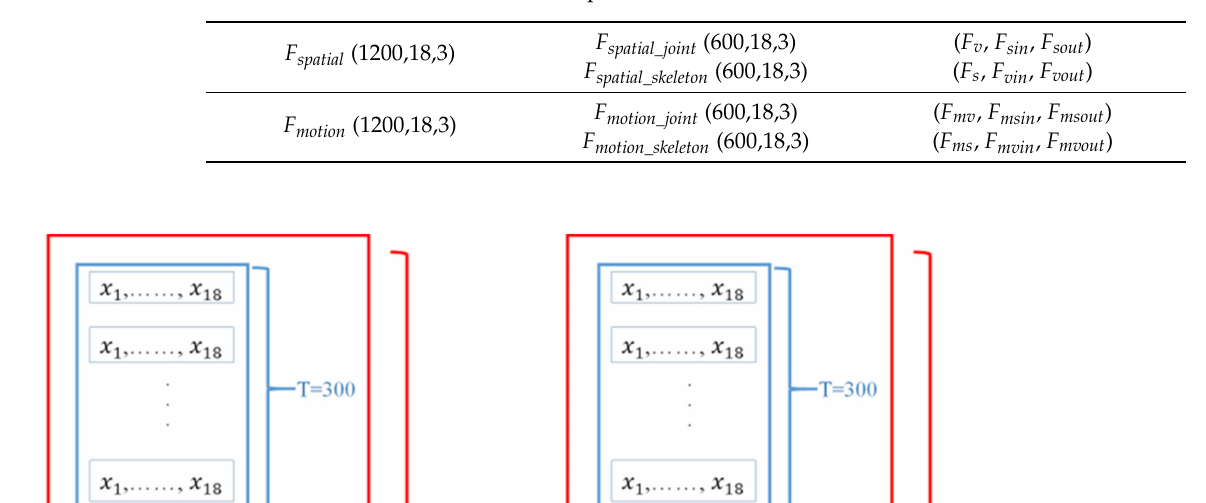
Table 3. The channel contents of the input features.